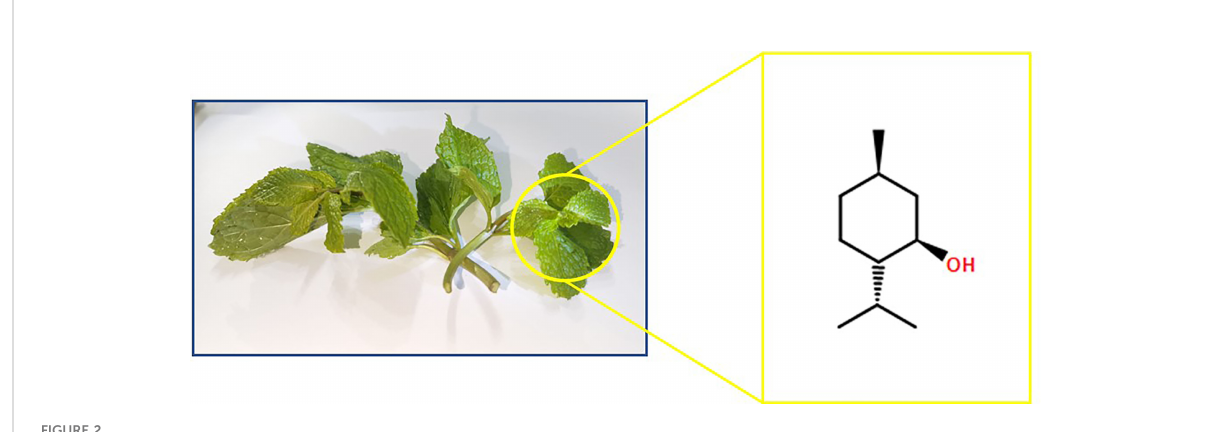
FIGURE 2 Chemical formula of L-menthol from mint